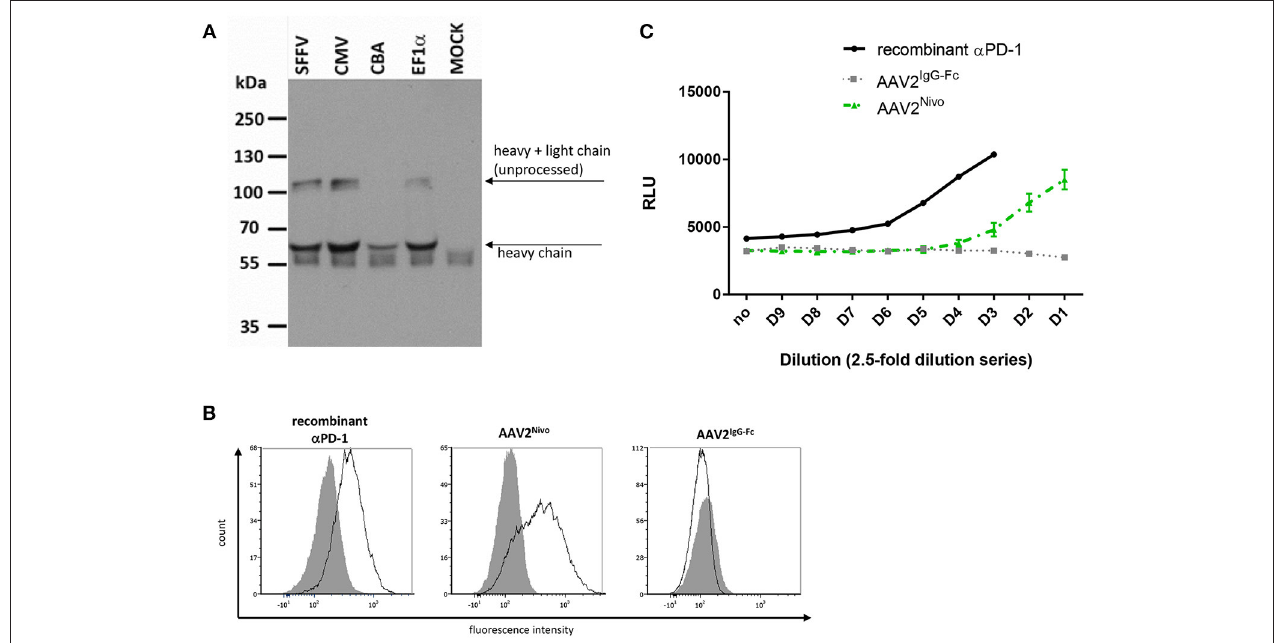
FIGURE 6 | AAV encoded nivolumab specifically binds its target antigen. Four days after transduction of MDA-MB-453 cells with AAV2 vectors encoding nivolumab, cell culture supernatants were collected and transgene expression was analyzed. Vectors encoding for IgG-Fc (flow cytometry) or GFP (MOCK in Western blot) served as negative controls. (A) Western blot analysis using an IgG-Fc-specific antibody. Vector constructs (non-purified small-scale productions) with different promoters were used. SFFV, spleen focus-forming virus; CMV, cytomegalovirus; CBA, chicken β -actin; EF1 α , human elongation factor 1 α . (B) Specific antigen recognition of AAV-encoded nivolumab from cell culture supernatants of cells transduced with gradient-purified SFFV-driven vector stocks and a commercial recombinant α PD-1 were assessed on PD-1 negative (Raji; gray shaded profiles) and PD-1 positive cells (MOLT4.8; empty profiles, black line) by flow cytometry. The binding of nivolumab was detected via an IgG-Fc-specific antibody. (C) Assay to analyze functionality of AAV-encoded nivolumab (gradient-purified large-scale SFFV-driven vector stocks were used). Reactivation of T cells due to PD-1 blockade is correlated with increased luminescence signal indicated as relative light units (RLU). AAV2 Nivo : green dashed line ( n = 2 technical replicates; mean ± SD); AAV2 IgG − Fc : gray dotted line ( n = 1); recombinant α PD-1: black line ( n =